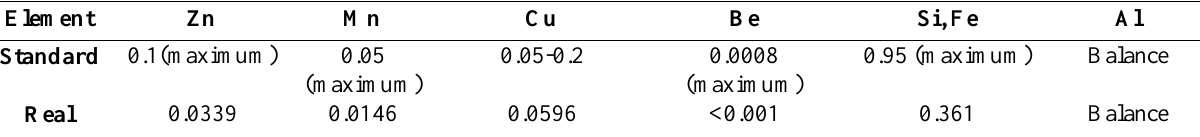
The Compositional analysis of AA 1100 alloy.